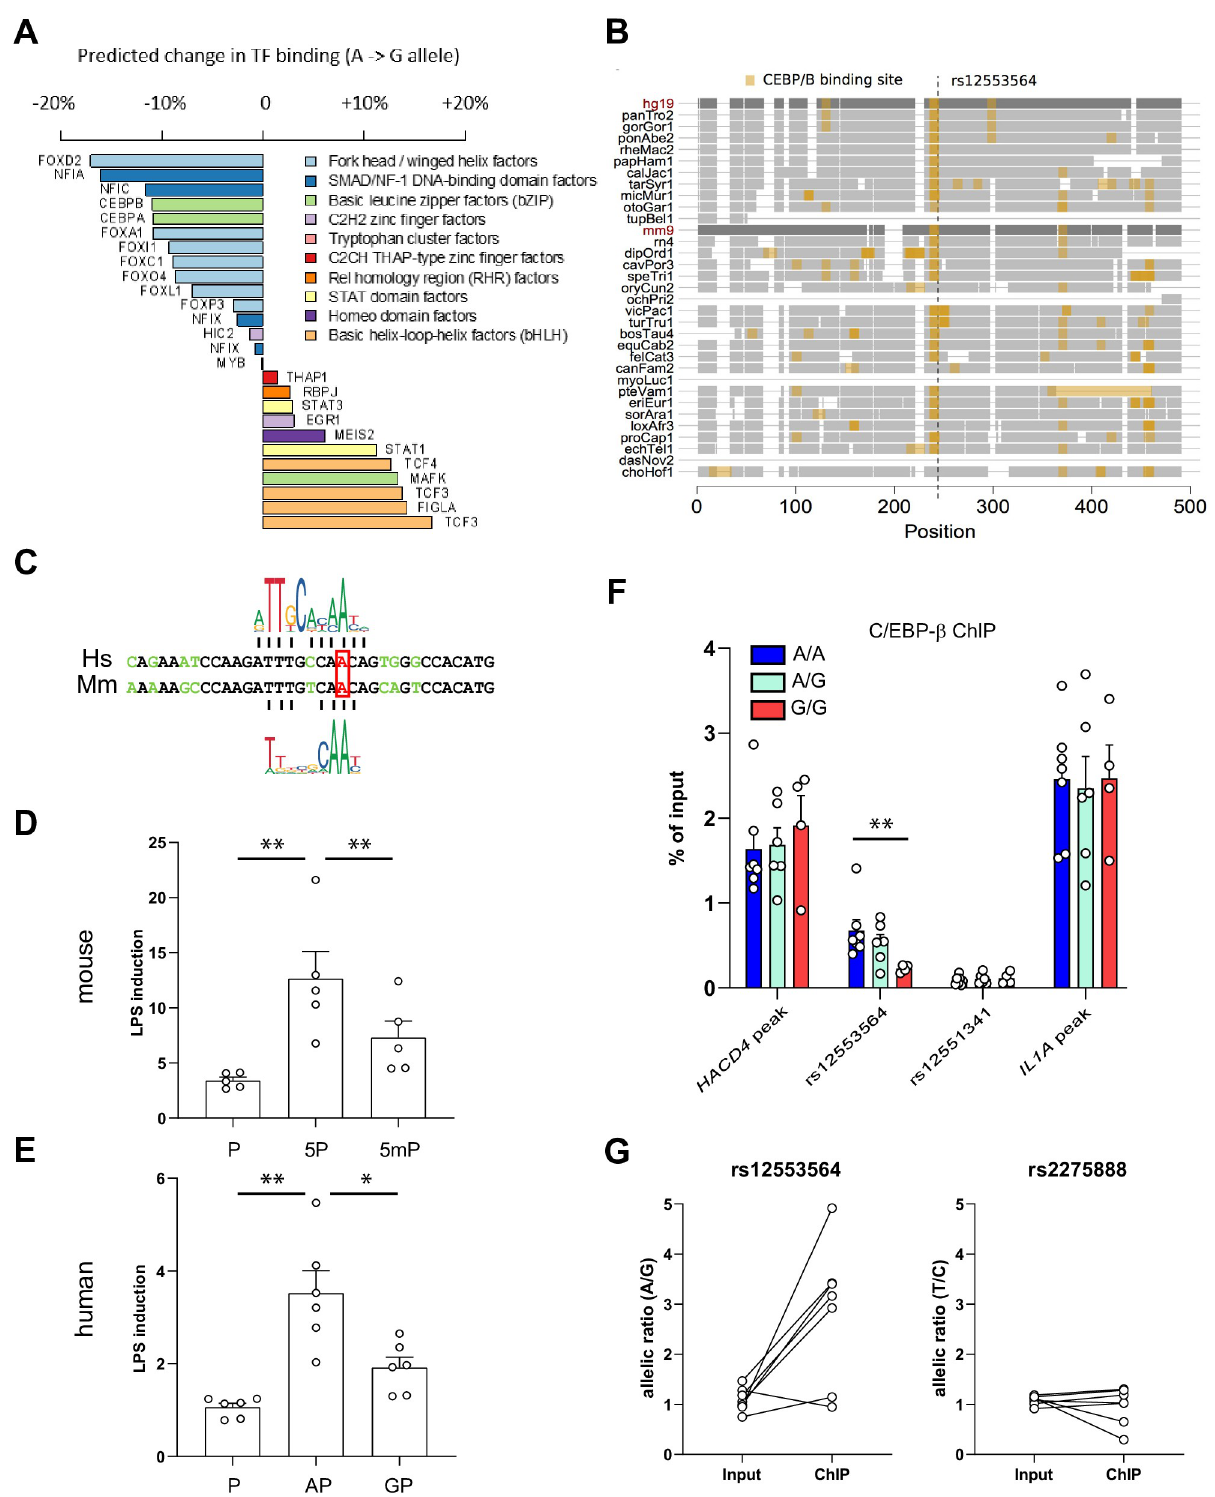
Fig 3. Role of C/EBP- β binding in FIRE function. ( A ) Predicted impact of rs12553564 on transcription factor binding. Difference in transcription factor binding scores between the derived (G) and ancestral (A) alleles at the rs12553564 locus. Only transcription factors with a binding score > 85% for either the ancestral or derived allele are reported. Transcription factors are colored according to the tertiary structure of their DNA binding domain. ( B ) Cross-species conservation of C/EBP- β binding site at the rs12553564 locus. Sequence alignment of 46 vertebrate species are displayed in a ~500 bp window around the rs12553564 variant. For each genome, only sequences aligning to the human or mice genome are shown, and are displayed by grey boxes. In each genome, matches to the human C/EBP- β motif ( > 85% of maximal score) are highlighted in orange. ( C ) Alignment of the human (Hs)